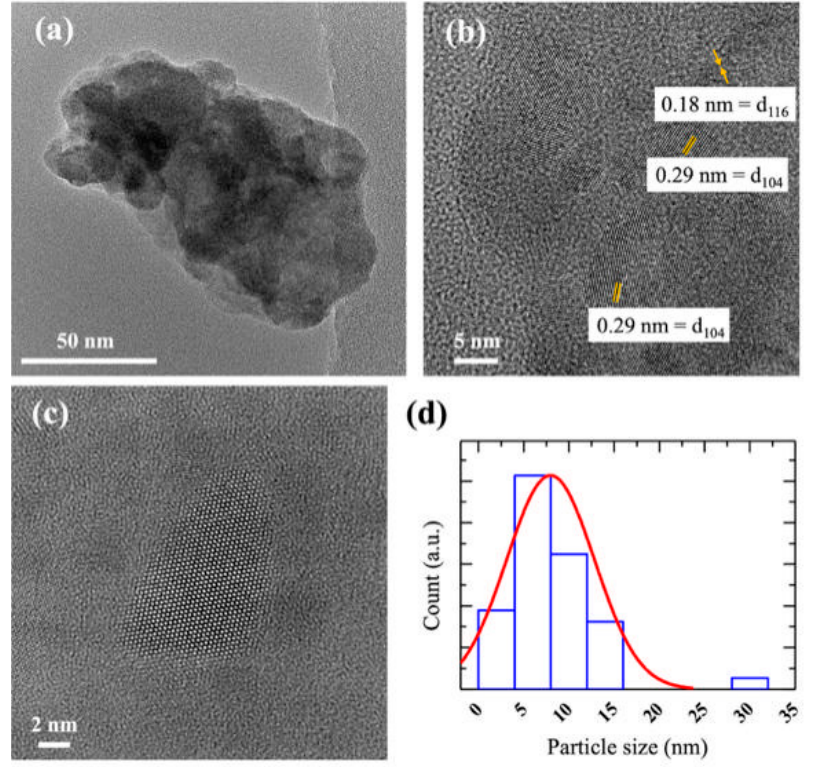
Figure 5. TEM images of the BFO nanoparticles. ( a ) A bright field TEM image of a set of particles. ( b , c ) HRTEM images of nanoparticles with different shapes and sizes. ( d ) The size distribution of the BFO nanoparticles implying the dominant size in the range of 5–10 nm.